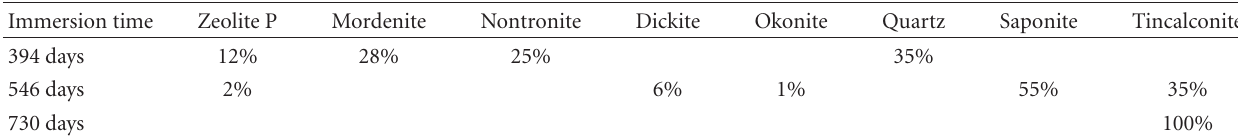
Table 3: Mineral distribution of secondary